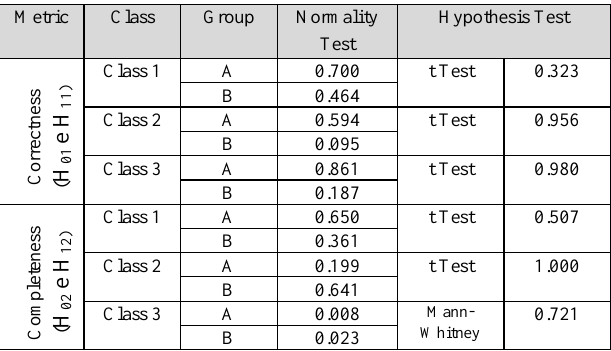
TABLE VII. R ESULTS FROM THE HYPOTHESES TESTS REGARDING THE QUALITY INDICATORS OF THE MODELS .